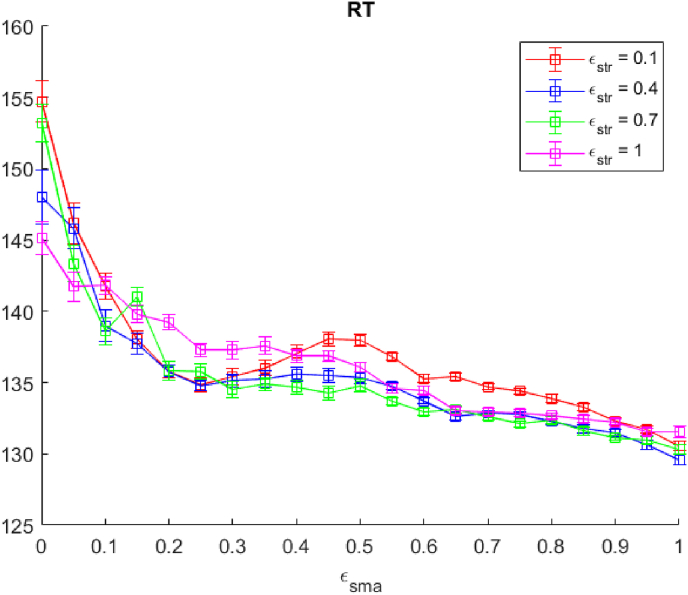
Response Time (in cycles) as a function of εsma for four different values of εstr. RT decreases as εsma increases, but is largely independent of εstr. Error bars show one standard error from the mean.